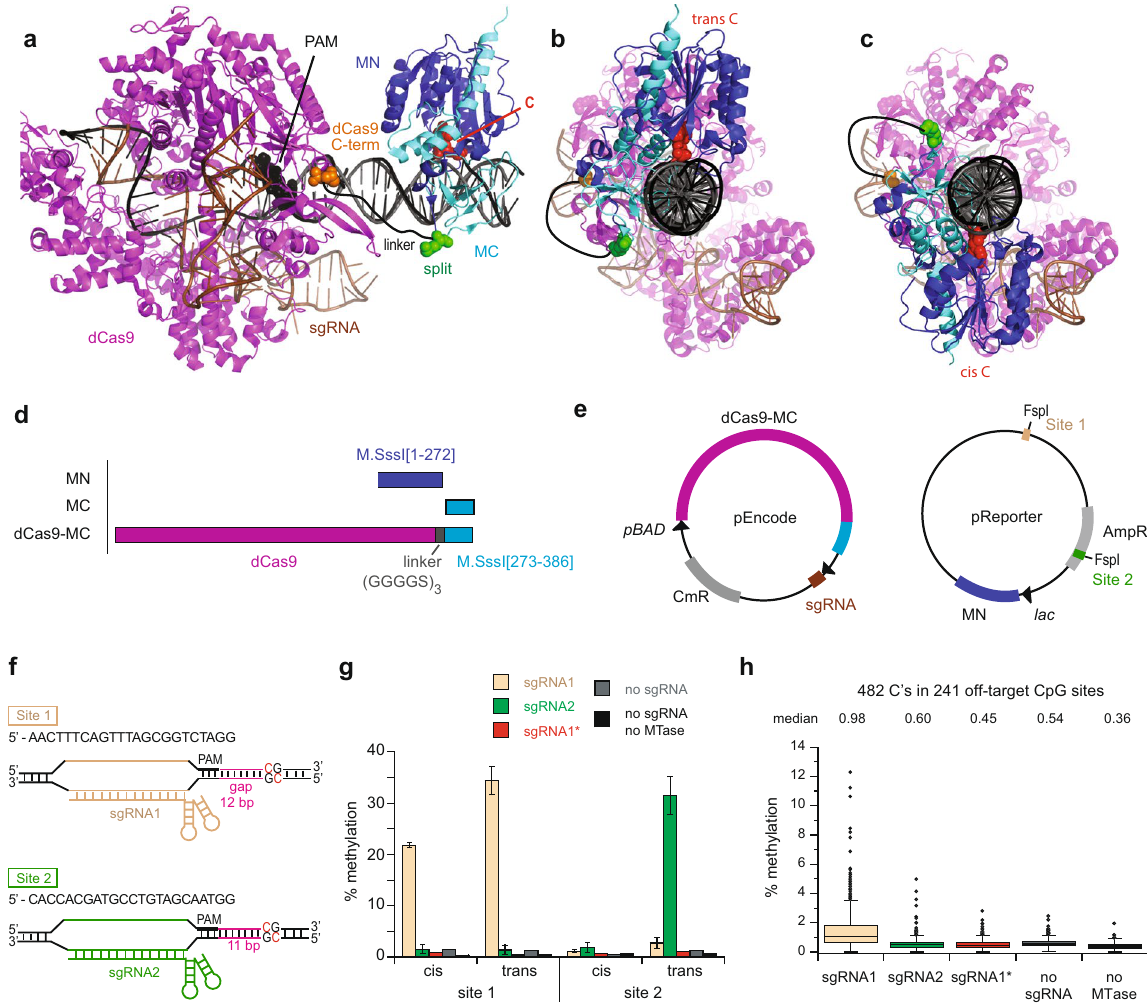
Figure 1. RNA-guided CpG methylation in E. coli . ( a ) Model of dCas9 and M.SssI bound to the same DNA at a gap of 11 base pairs between the PAM and the target CpG site. Model was built by superimposing the crystal structures of DNA-bound dCas9 (4UN3) 37 and the M.SssI homolog M.HhaI (2HR1) 55 on the same molecule of B-DNA. M.HhaI is bound to the trans strand relative to the PAM site. Red indicates the methylated cytosine, which is flipped out of the dsDNA. A hand-drawn black line represents the 15-amino acid linker between the C-terminus of dCas9 (orange) and the N-terminus of MC (green). The linker was not explicitly modeled. ( b , c ) Side views of the model with M.HhaI bound to the trans or cis strand at a gap length of 11 base pairs. ( d ) Protein constructs used in E. coli studies. ( e ) Two-plasmid system for expressing dCas9-MC/MN and sgRNA and assaying methylation in E. coli . pReporter contains two target sites for methylation in which the CpG site is imbedded within an FspI site. ( f ) DNA sequence near the two target CpG sites for methylation indicating the PAM site (bold) and its distance from the CpG site (the gap). Full sequence of sgRNAs can be found in Supplementary Table S1. ( g ) Frequency of methylation at site 1 and site 2 on pReporter caused by dCas9-MC/MN as assayed by high-throughput bisulfite sequencing. The sgRNA expressed is indicated as is the no methylation control. sgRNA1 * indicates that sgRNA1 was expressed, but that the site 1 protospacer and PAM sequences were scrambled. Values are the mean and the error bars are the standard deviation of three independent cultures. ( h ) Frequency of methylation at all off-target cytosines in CpG sites in pReporter as assayed by high-throughput bisulfite sequencing. The pattern of methylation on the plasmids can be found in Supplementary Figure